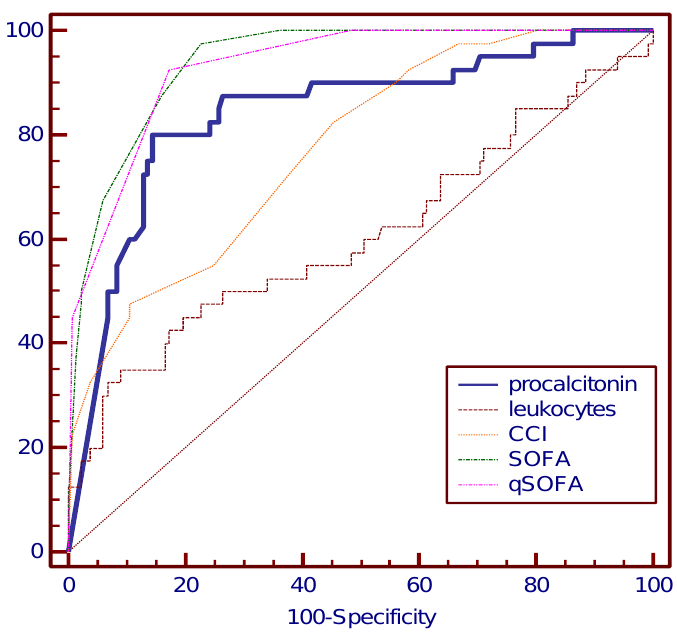
Figure 4. Pairwise comparison of ROC curves for the septic shock group.